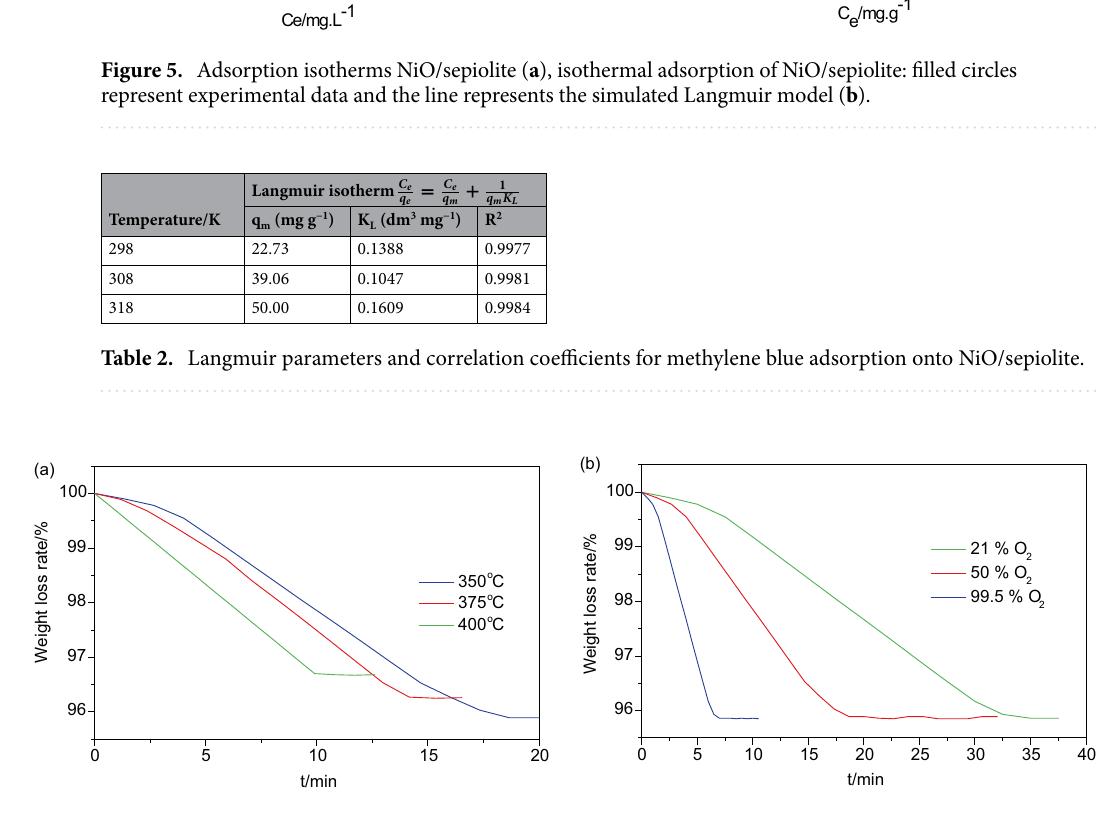
Figure 6. TG curves obtained in the degradation of methylene blue adsorbed on NiO/sepiolite at different temperature ( a ). TG curves obtained in the degradation of methylene blue adsorbed on NiO/sepiolite at different volume fraction of O 2 ( b